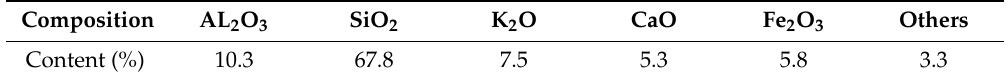
Figure 2. Distribution curves of the particle size of aeolian sand and fly ash. Table 1. Aeolian sand composition.